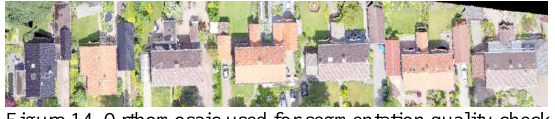
Figure 14. Orthomosaic used for segmentation quality check